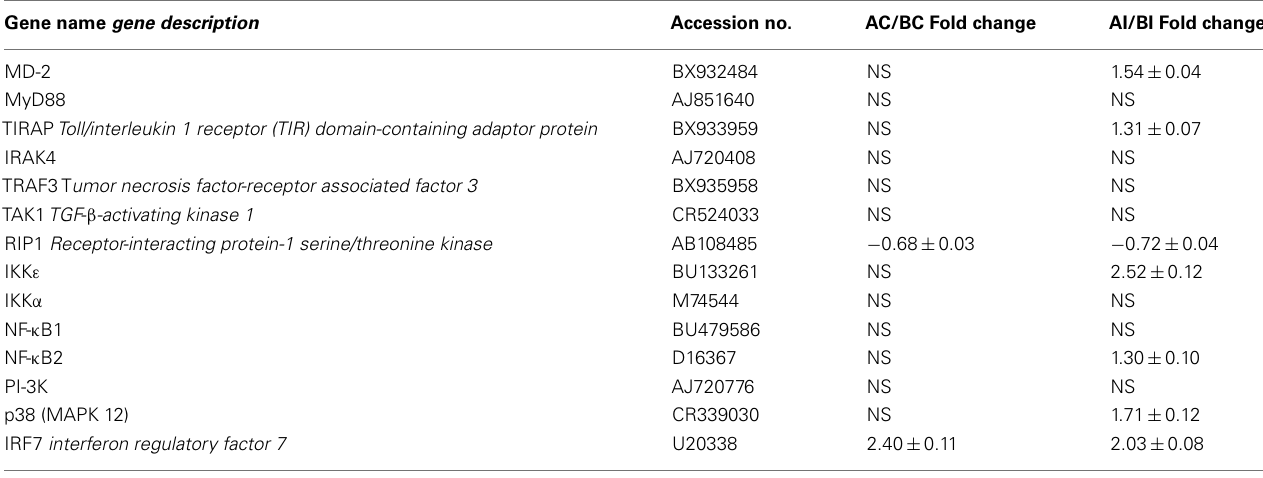
Table 4 | Fold change ofToll-like receptor pathway genes between heterophils isolated from lineA and B chickens using microarray